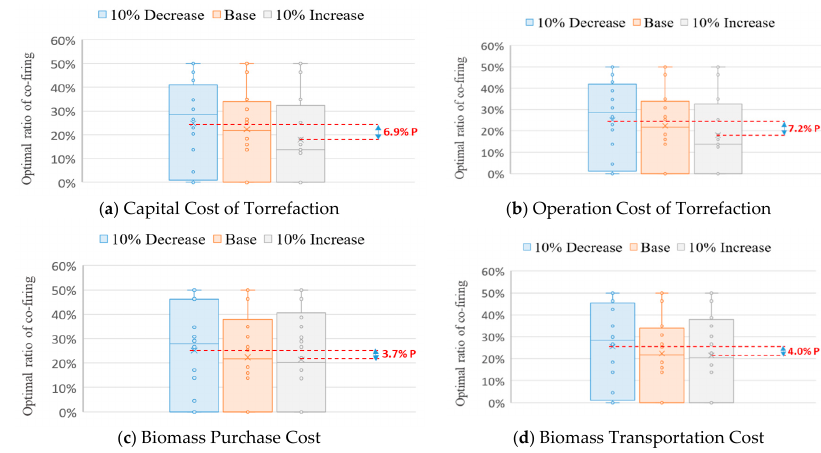
Figure 9. Changes of optimal level of co-firing based on ±10% cost variations. ( a ) Capital Cost of Torrefaction; ( b ) Operation Cost of Torrefaction; ( c ) Biomass Purchase Cost; ( d ) Biomass Transportation Cost.